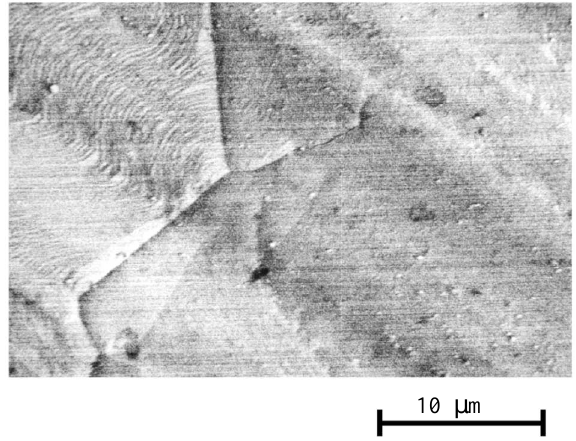
FIG. 11. SEM image of the diamond-turned surface. Grain boundary grooves are visible after annealing.